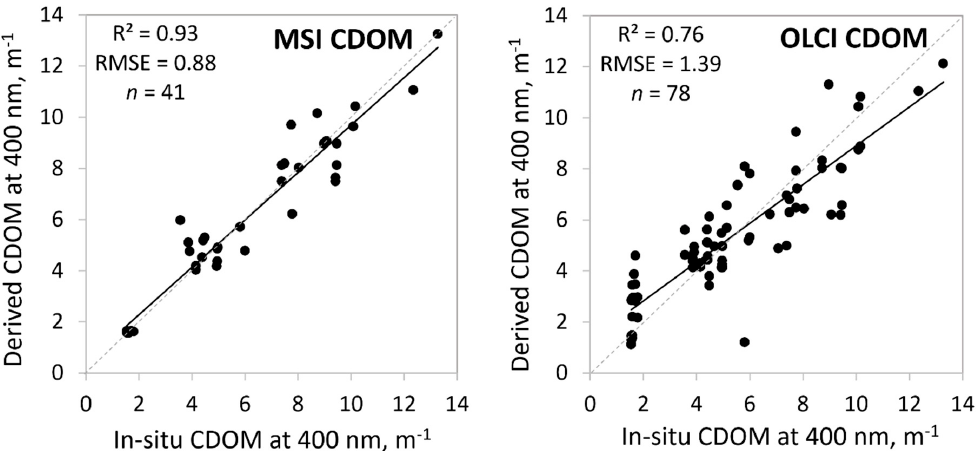
Figure 8. Correlation between in-situ and satellite derived colored dissolved organic matter (CDOM) at 400 nm based on the optical water types (OWTs). Also, R 2 , RMSE, and the number of samples ( n ) are given. Table 5. The best MSI and OLCI band ratios and their R 2 and RMSE for colored dissolved organic matter (CDOM) at 400 nm based on the optical water types (OWTs).